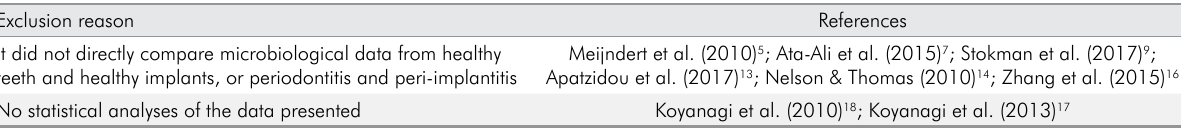
Table 2. Reasons for